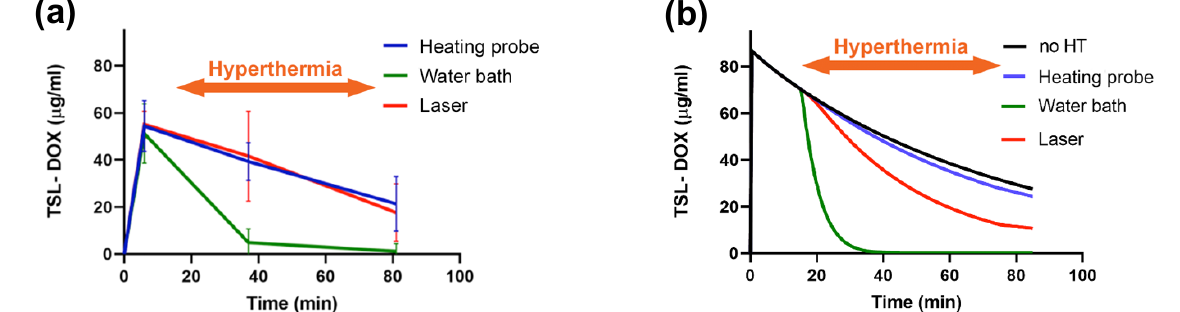
Figure 15. Volumetric heating rapidly depletes systemically available TSL-encapsulated drug. ( a ) Plasma pharmacokinetics of mice injected with TSL-Dox is shown, for three heating modalities. The focal heating modalities (heating probe, laser) have little impact on plasma concentration (e.g., plasma half-life was similar to a prior study in the same animal model without heating [30]). In contrast, water bath heating—where the whole limb is exposed to heat rather than just the tumor— rapidly depletes encapsulated drug in systemic plasma. ( b ) Pharmacokinetic model shows similar results at higher temporal resolution, and includes results in unheated mice (‘no HT’). Figures reproduced from [162] (published under CC BY